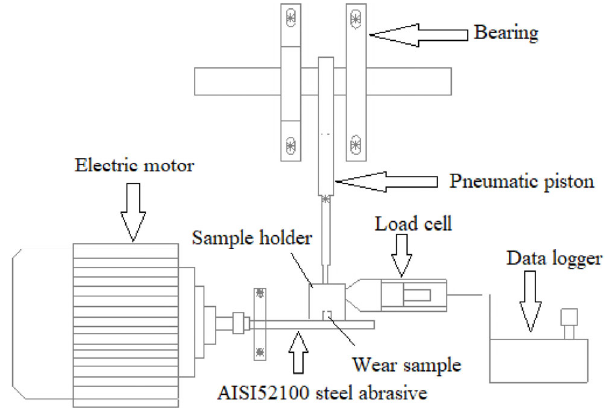
Fig. 4 Schematic of block-on-disc wear test